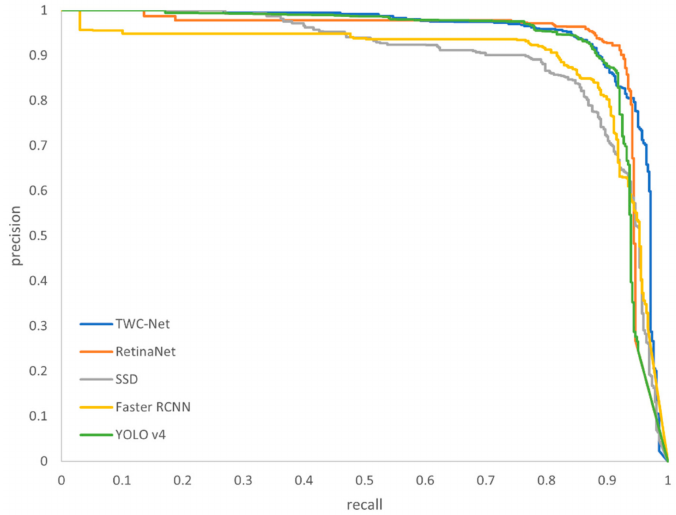
Figure 8. Precision–recall curves of different detection